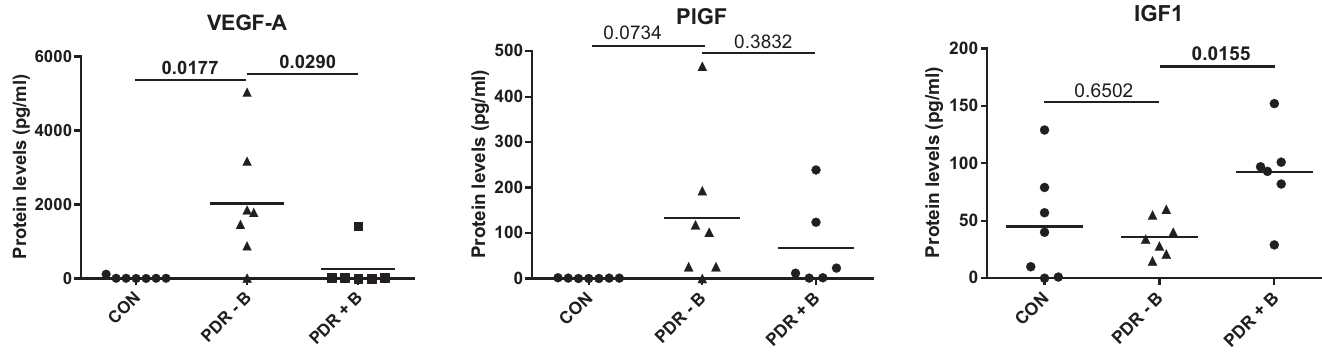
Fig 2. Effect of anti-VEGF therapy on protein levels. Samples were dividedin three groups: CON, non-diabetic control patients; PDR—B, PDR patients that did not receivebevacizumab;PDR + B, PDR patients that receivedbevacizumab. Differencesbetween groupswere analyzedwith an unpairedt test with Welch’s correction. Lines represent mean